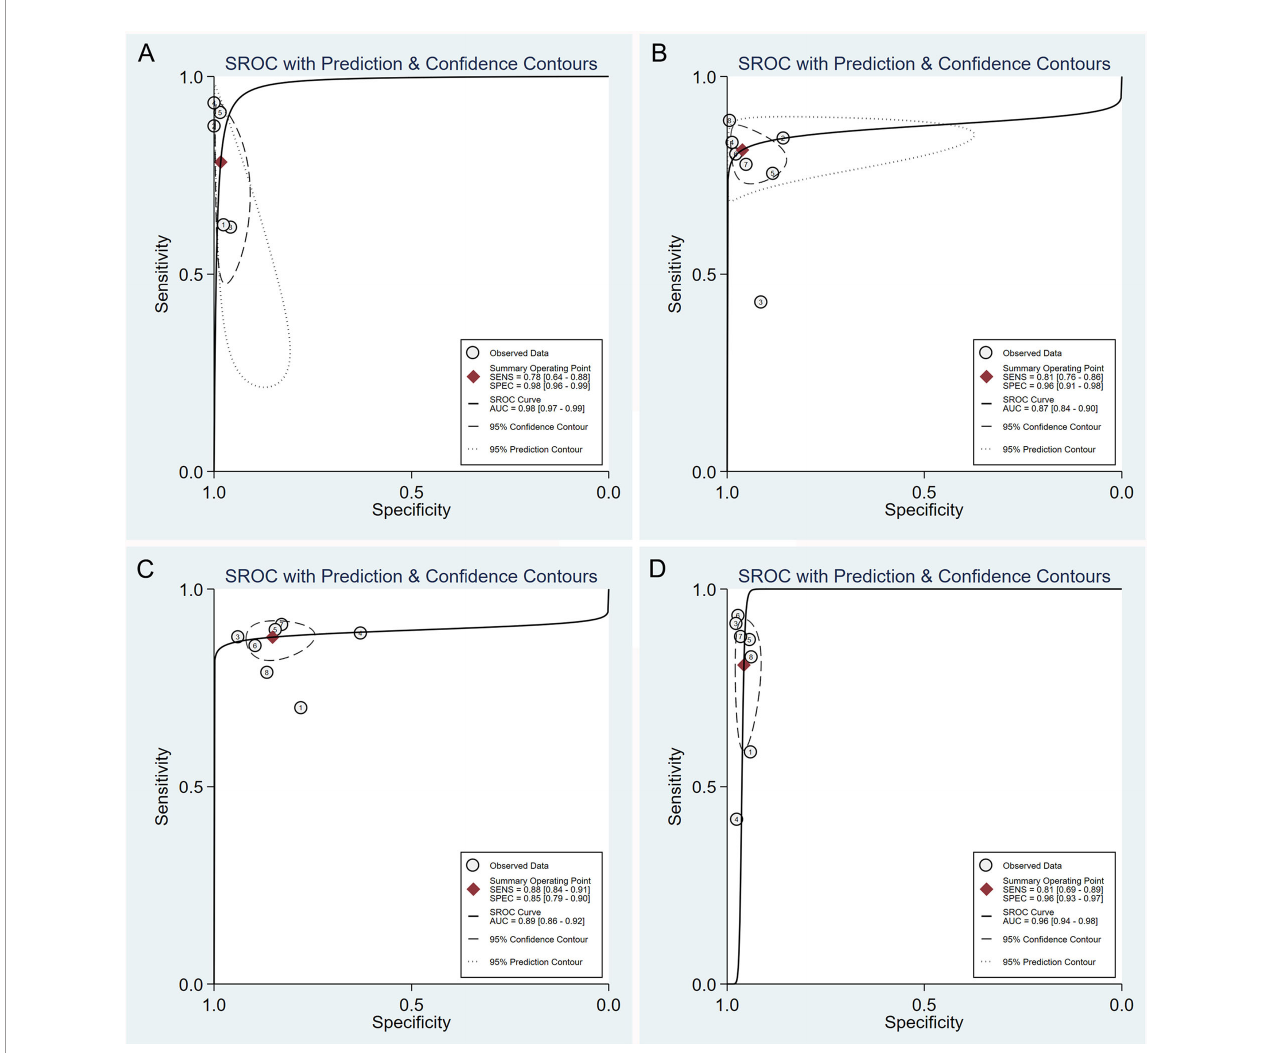
FIGURE 3 | Summary receiver operating characteristic plot of studies assessing the accuracy of double contrast-enhanced ultrasonography in diagnosing T1 (A) , T2 (B) , T3 (C) , and T4 (D) gastric tumors. Each study sensitivity/speci fi city value is represented by an empty circle. The summary point for sensitivity/speci fi city is represented by a black- fi lled circle. Dotted closed line, 95% con fi dence interval of the summary point; dashed closed line, 95% prediction